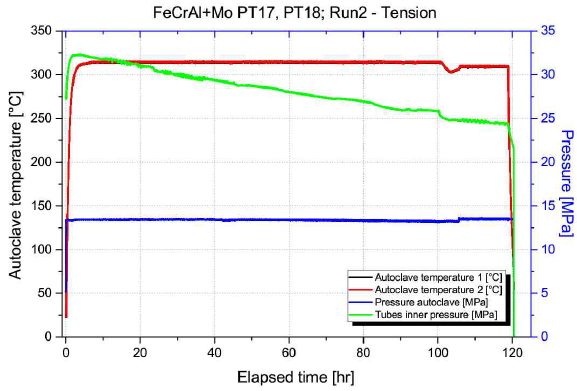
Figure 11. FeCrAl+Mo Run 2 - autoclave tempera- ture and pressure, inner tube